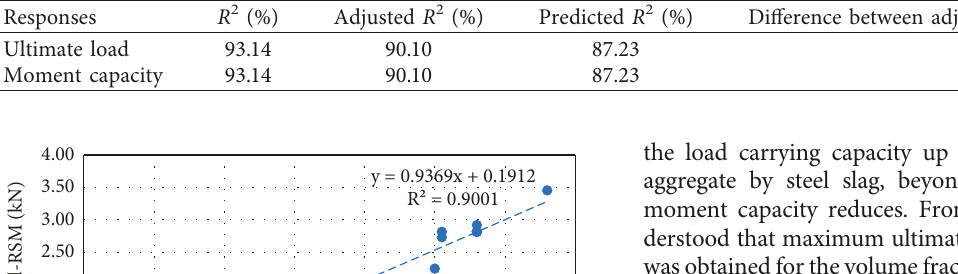
Table 5: proportion of variance ( R 2 ) of the regression model.